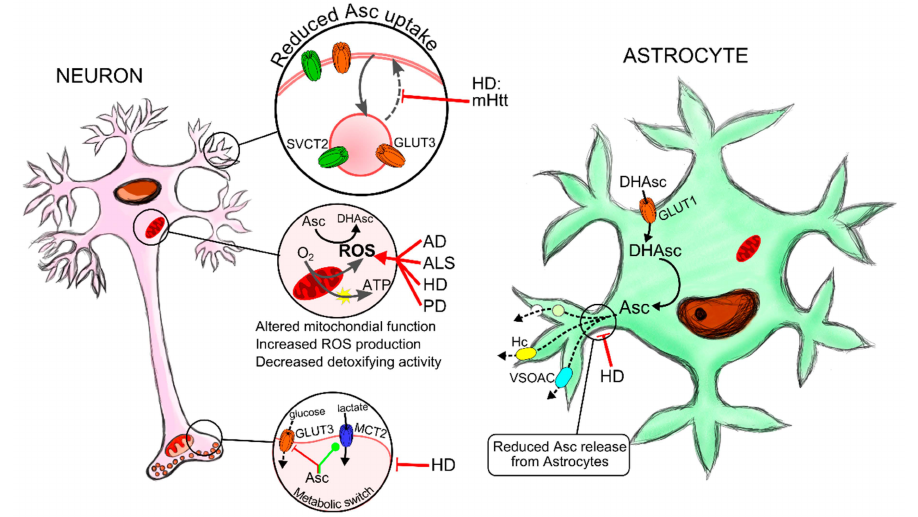
Figure 2. Failure in ascorbic acid homeostasis contributes to neurodegeneration. Neuronal TCA (tricarboxylic acid) and oxidative phosphorylation are highly efficient mechanisms in sustaining synaptic activity. However, the continued use of oxygen generates reactive oxygen species (ROS), which leads to oxidative stress. Therefore, neuronal metabolism and synaptic signalling induce ROS production. Neurons are highly sensitive to oxidative stress and thus ascorbic acid recycling by astrocytes and neuronal uptake through SVCT2 transporters are important mechanisms in maintaining antioxidant defence. During aging as well as in neurodegenerative diseases there is an imbalance in ROS production, decreased levels of antioxidant molecules and impairment in detoxifying enzyme activity such as superoxide dismutase (SOD) or catalase. In HD, accumulation of mutant Huntingtin protein alters mitochondrial biogenesis and expression of antioxidant defence genes, increasing oxidative damage leading to neuronal death. Amyloid β peptide and α -synuclein protein aggregation and neuronal death in both pathologies. SOD1 loss of function due to